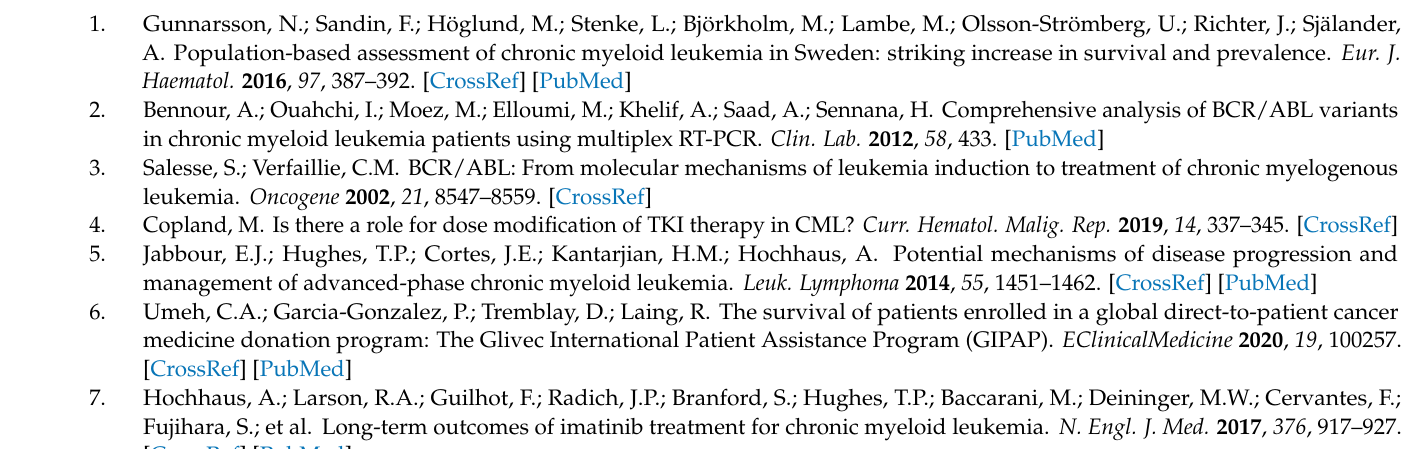
(Supplementary Table S1), and protein interaction subnetworks of the TKI responses gene mark- ers